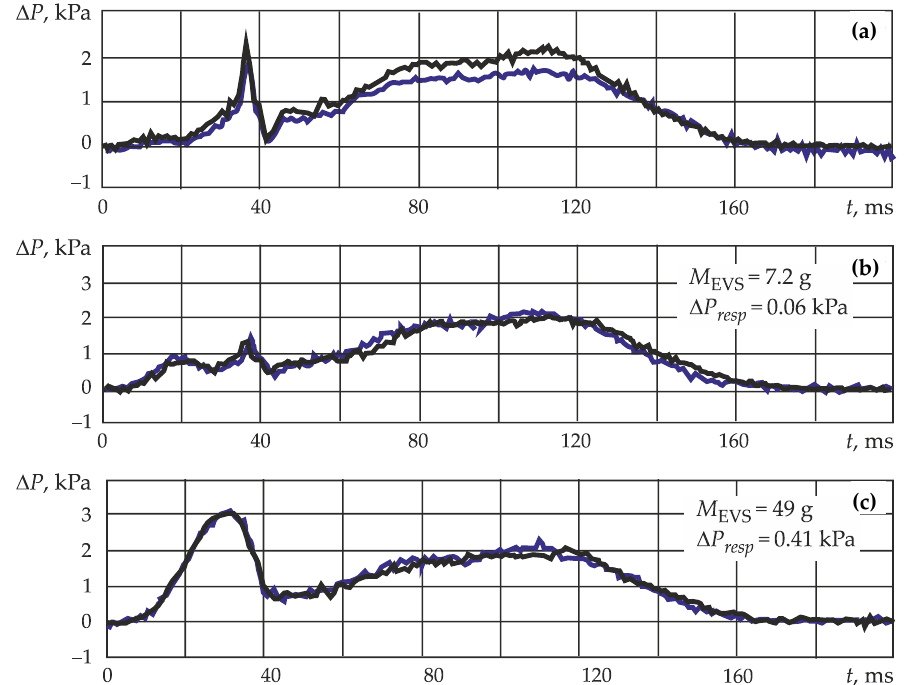
Figure 1. Experimental waveforms for an explosion of a propane-air mixture in a cubic chamber (h = 305 mm): ( a ) uncovered openings; ( b ), ( c ) openings covered with EVS-simulating panels.